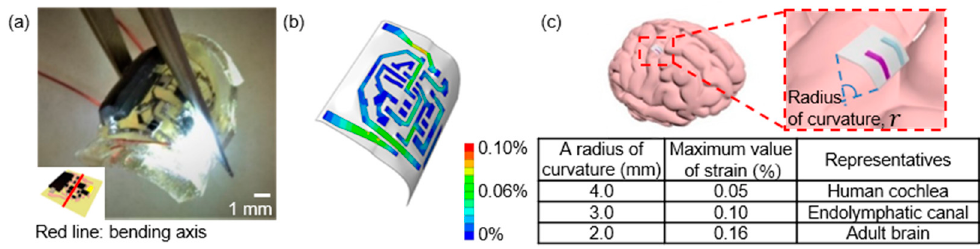
Figure 3. Mechanical characteristics of a surgical lighting patty. ( a ) Image of the flexible surgical lighting patty. Here, a central lighting layer is removed from the patty for the purpose of clarity. ( b ) Corresponding finite element modeling results of the patty after bending (a radius of curvature 3 mm). Here, the patty is bent to a radius of 3 mm. For R = 3 mm, the maximum effective strain in copper is 0.1%, which is lower than its fracture strain (5%). ( c ) Schematic illustration of the patty mounted on the brain. Here, the surgical lighting patty forms an intimate contract with the surface of the human brain. A radius of curvature for representative organ systems is summarized in a table.